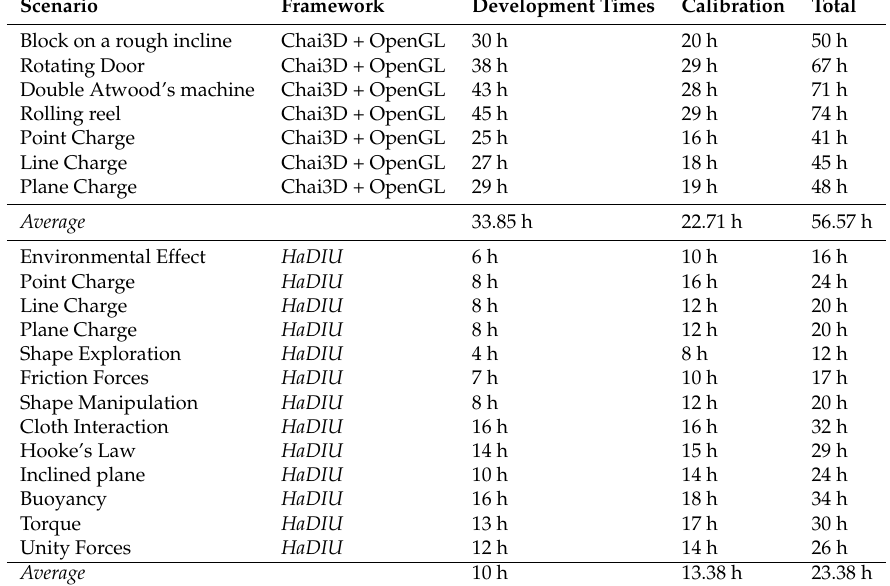
Table 4. Development time comparison table for previous application developed by the authors and the scenarios developed using